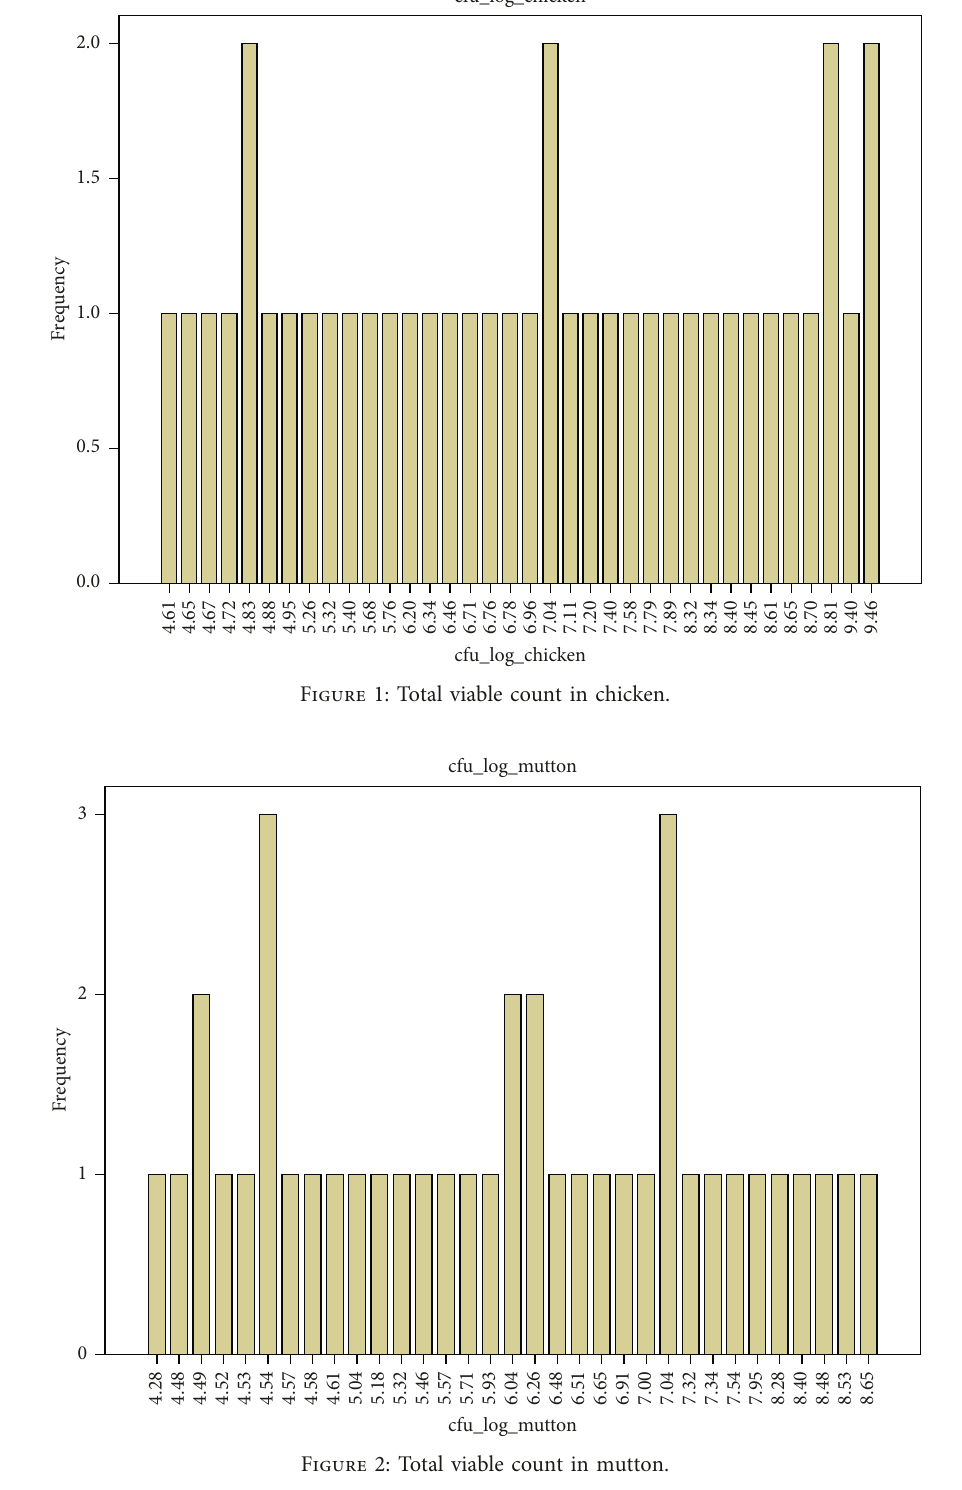
Figure 2: Total viable count in